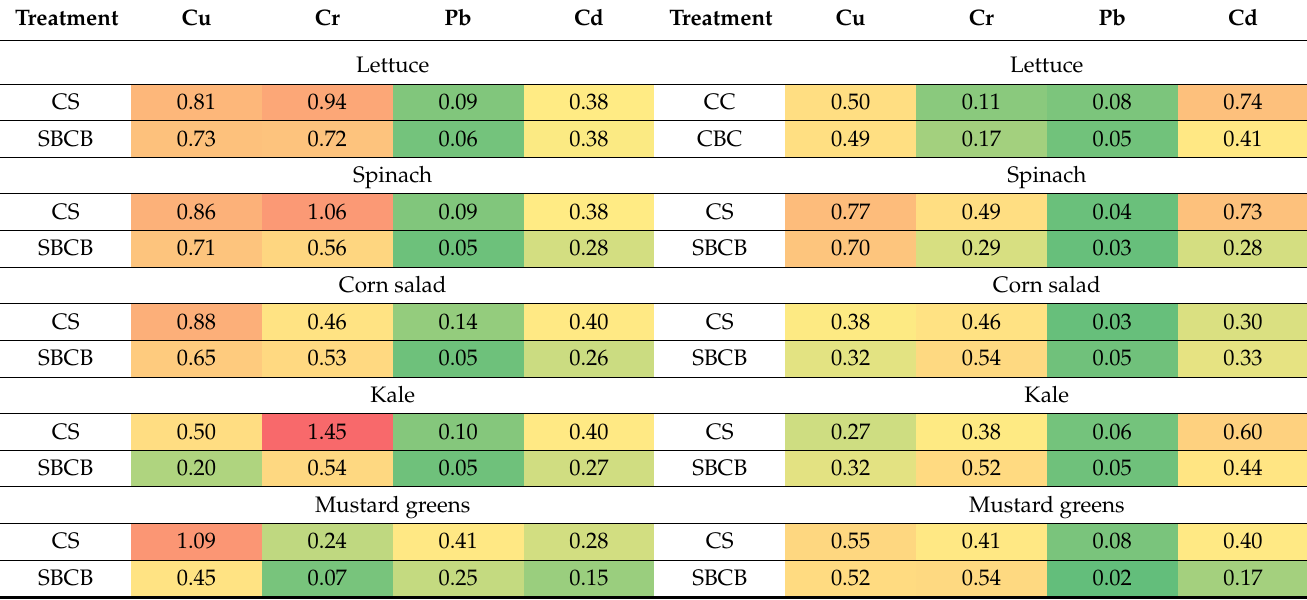
Table 5. Bioaccumulation coefficient (BAC) of Cu, Cr, Pb and Cd in five species of green